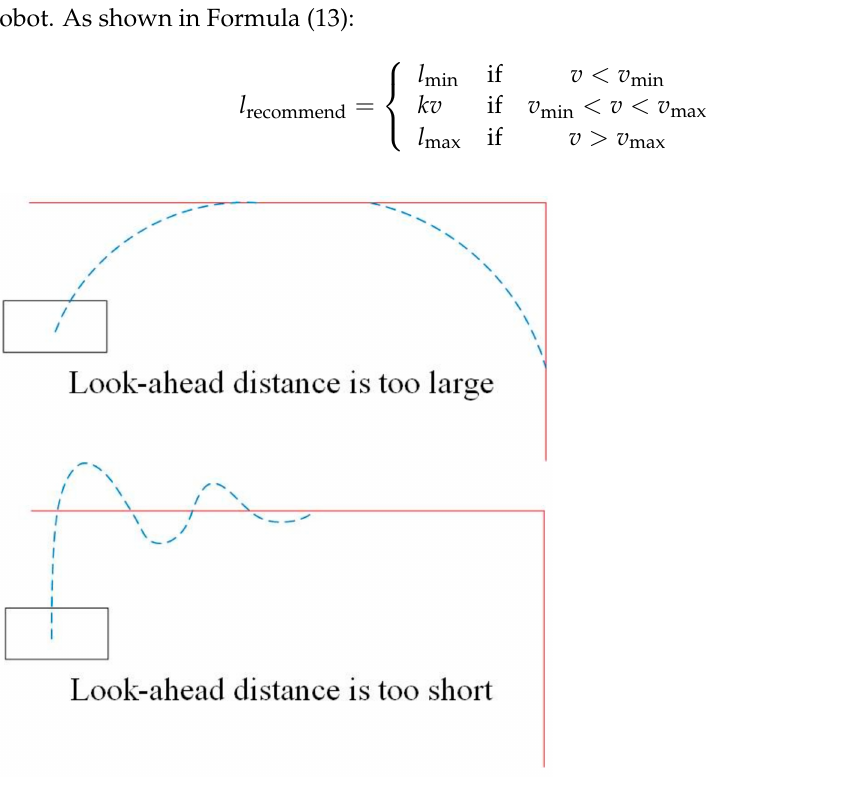
Figure 12. The problems of pure pursuit when look-ahead distance is too large or too small. Recommended look-ahead distances do not represent reasonableness. For the choice of look-ahead distance, there are two goals to be achieved: fit the track and run